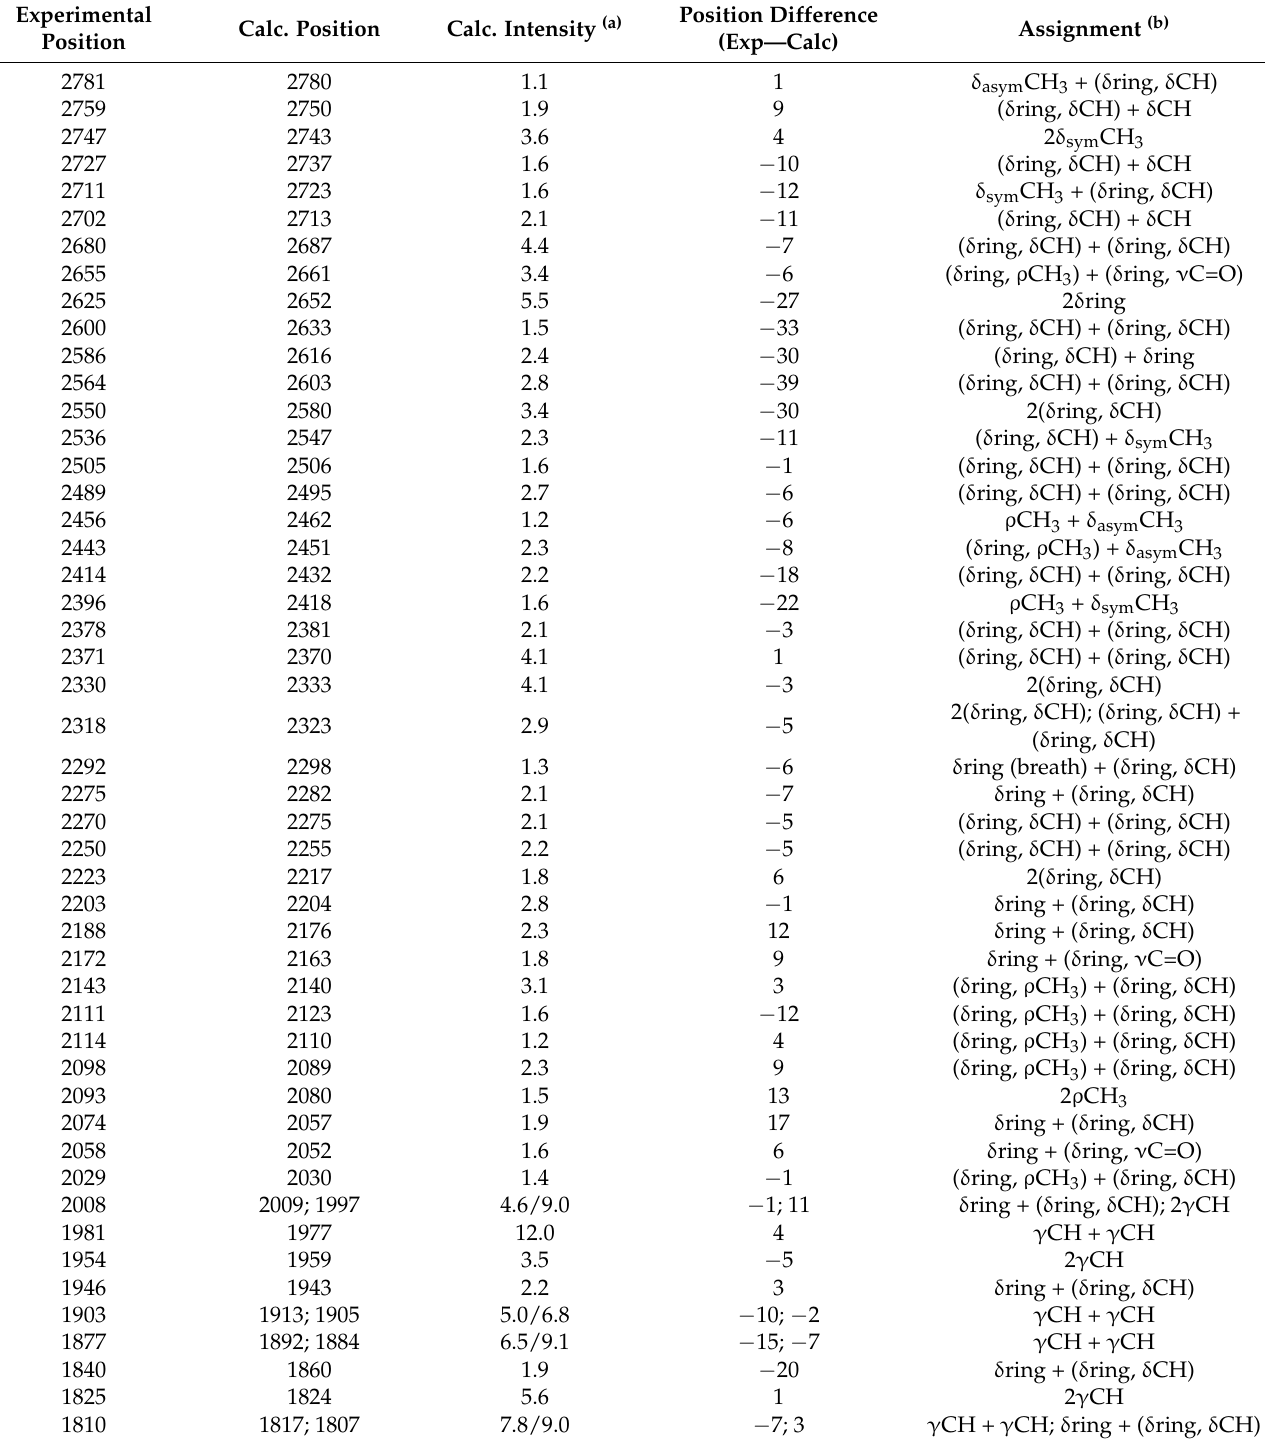
Table 4. Experimental and calculated band positions [cm − 1 ] together with calculated relative intensities [%] (normalized to the intensity of 3063 cm − 1 band; see Table 2) and assignments of the fundamental bands in the 2800–1800 cm − 1 range for crystalline